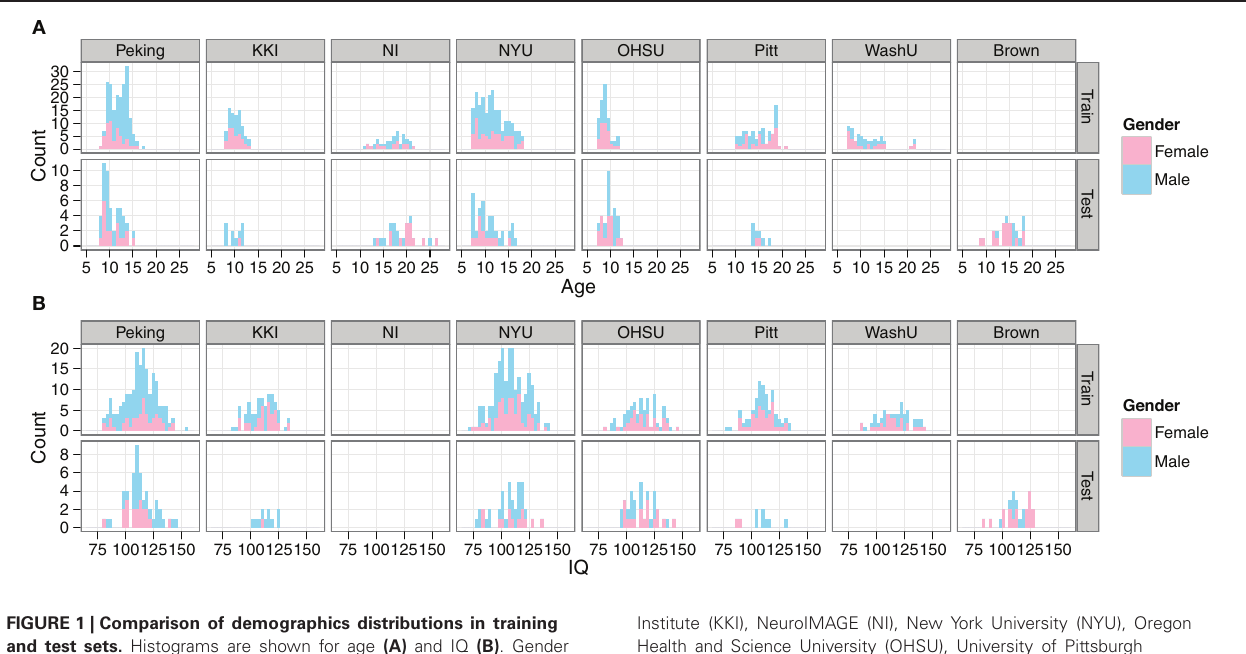
FIGURE 1 | Comparison of demographics distributions in training and test sets. Histograms are shown for age (A) and IQ (B) . Gender is encoded by color. Plots are facetted by Site and training/test set. Site abbreviations: Peking University (Peking), Kennedy Krieger